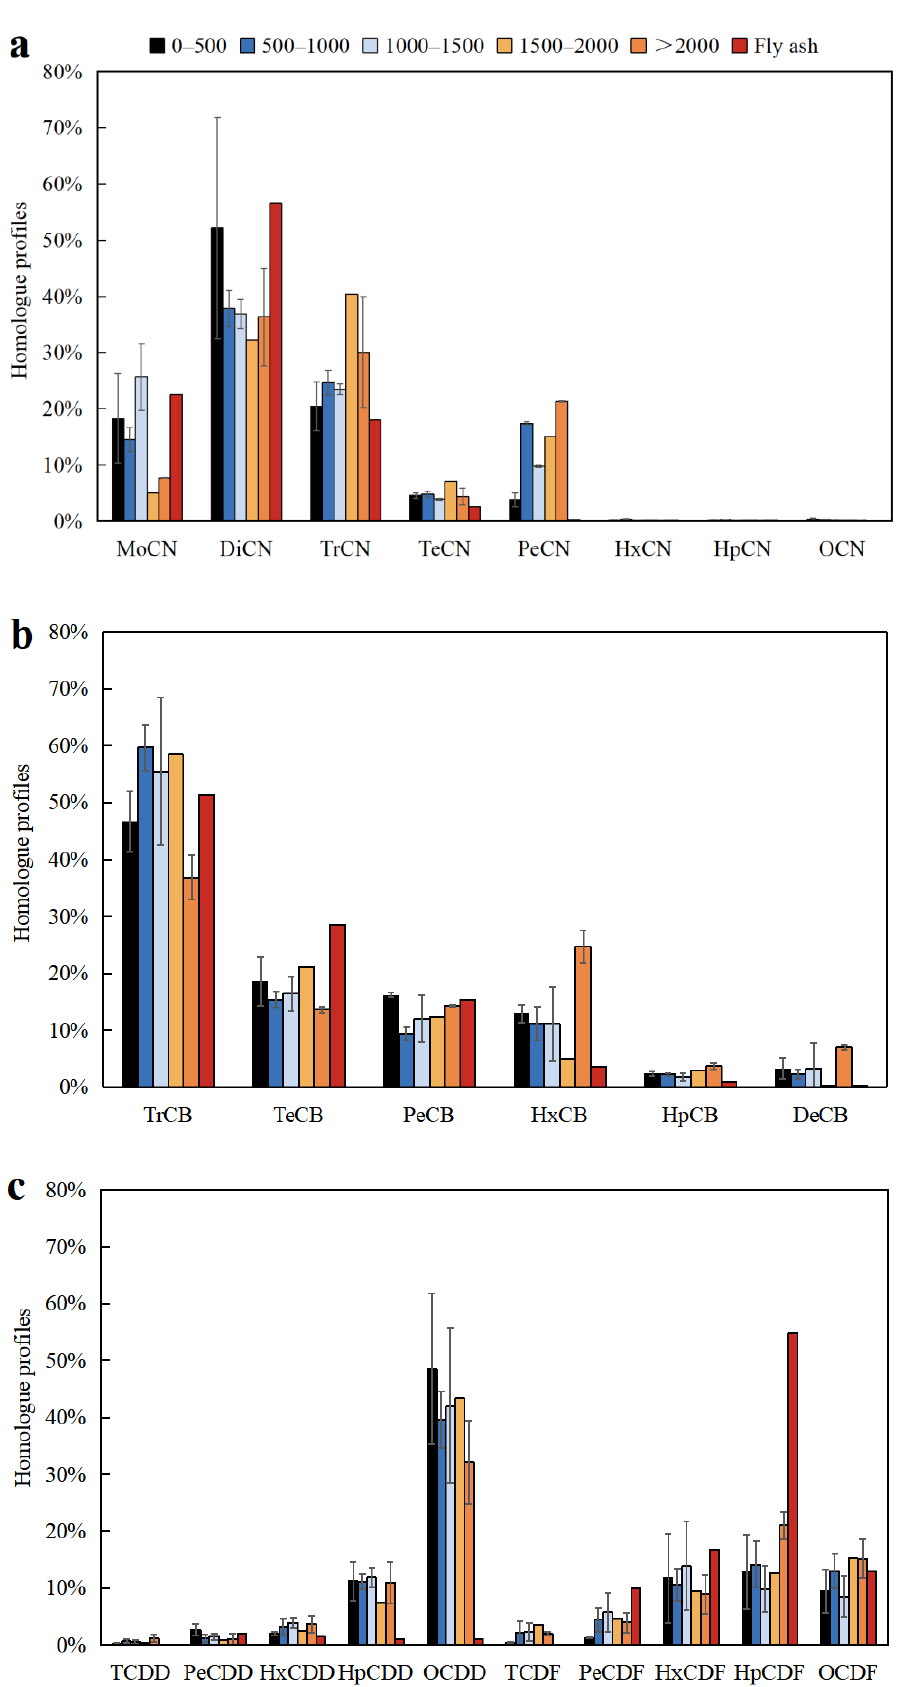
Figure 3. Homologue patterns of PCNs ( a ), PCBs ( b ), and PCDD/Fs ( c ) in the fly ash and soil